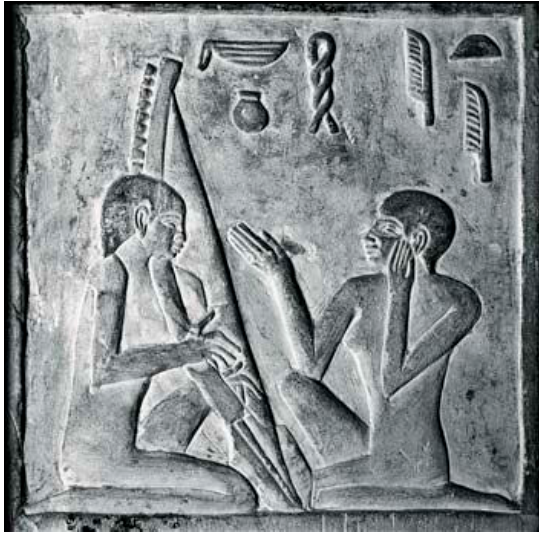
Figure 25. Ancien Egyptian singer, Iti in Tomb of Nikaw-ra. © Egyptian Museum Cairo.